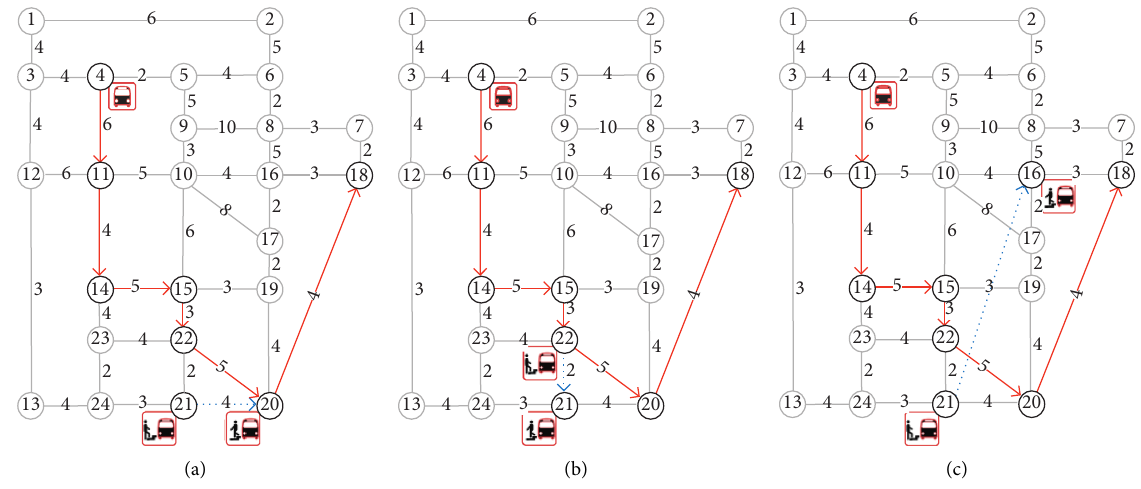
Figure 2: The customized bus system